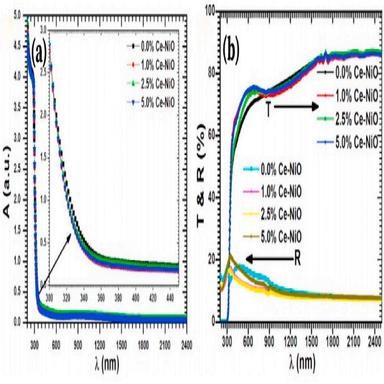
((a) and (b)) UV-VIS-NIR absorbance, transmittance and reflectance plots of pure and doped NiO thin films .